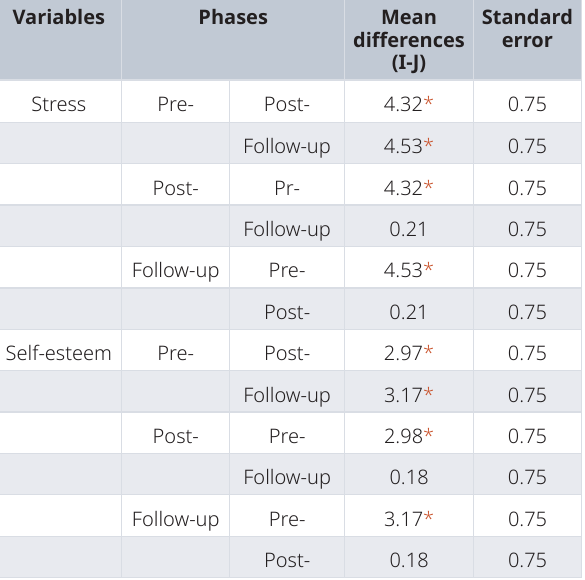
Table 5. Post hoc analysis for the pre-, post-, and follow-up phases of intervention for stress and self-esteem.